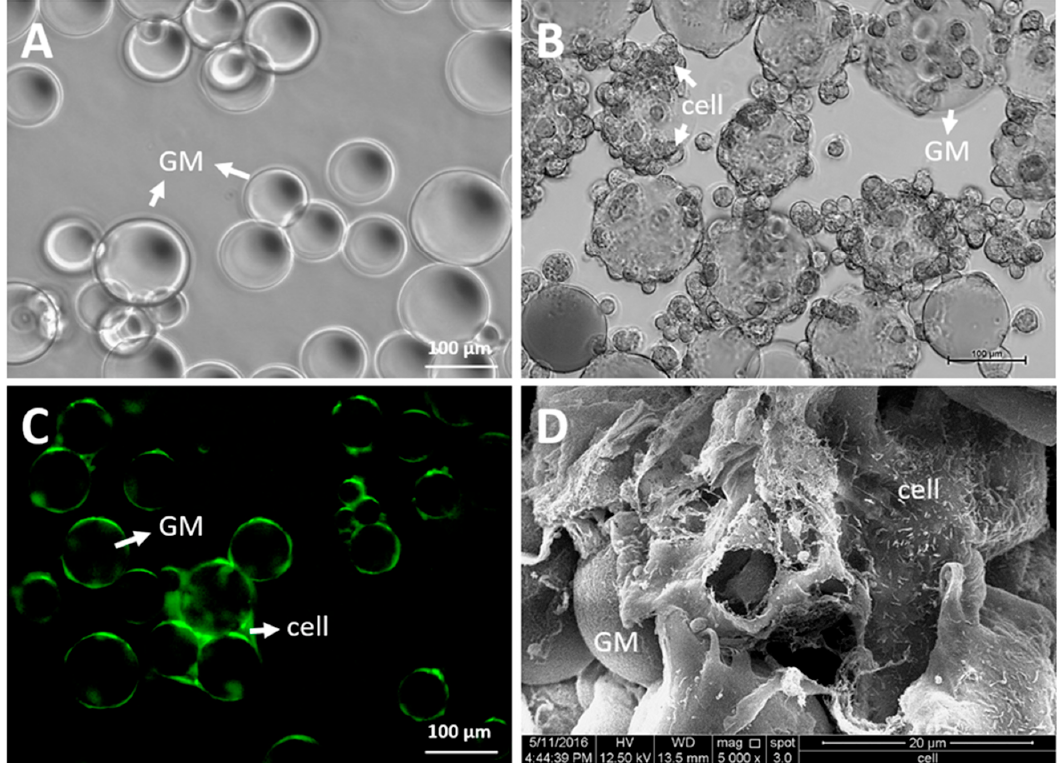
Figure 2. Microscopic images of gelatin microsphere (GM). ( A ) GM suspended in the buffer (under the phase-contrast microscope), ( B ) chondrocyte-laden GM (under the phase-contrast microscope), ( C ) chondrocyte-laden GM aggregates (under fluorescence microscope; green—CellTracker™ Green CMFDA fluorescent dye), and ( D ) chondrocytes attachment on GM (under scanning electron microscope). (unpublished data, Shamsul et al.).